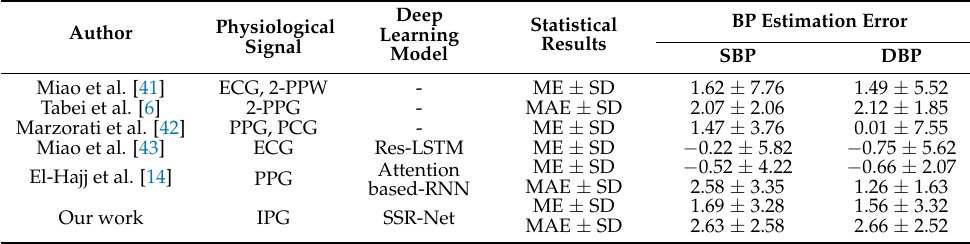
Table 2. Comparison of cuffless continuous BP measurement